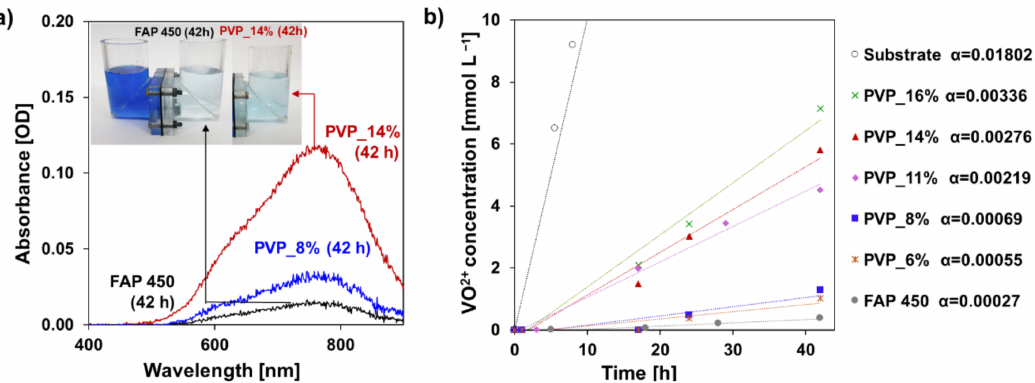
Figure 4. ( a ) UV-Vis spectra of receiving solutions at 42 h from the beginning of the permeability test (PVP_14%, PVP_8% and FAP 450), the picture inset shows the permeability test cells at the time of sampling; ( b ) anion exchange membranes per- meability test results–VO 2+ concentration vs. time, the α coefficients are calculated as the slopes of vanadium concentration curve in a function of